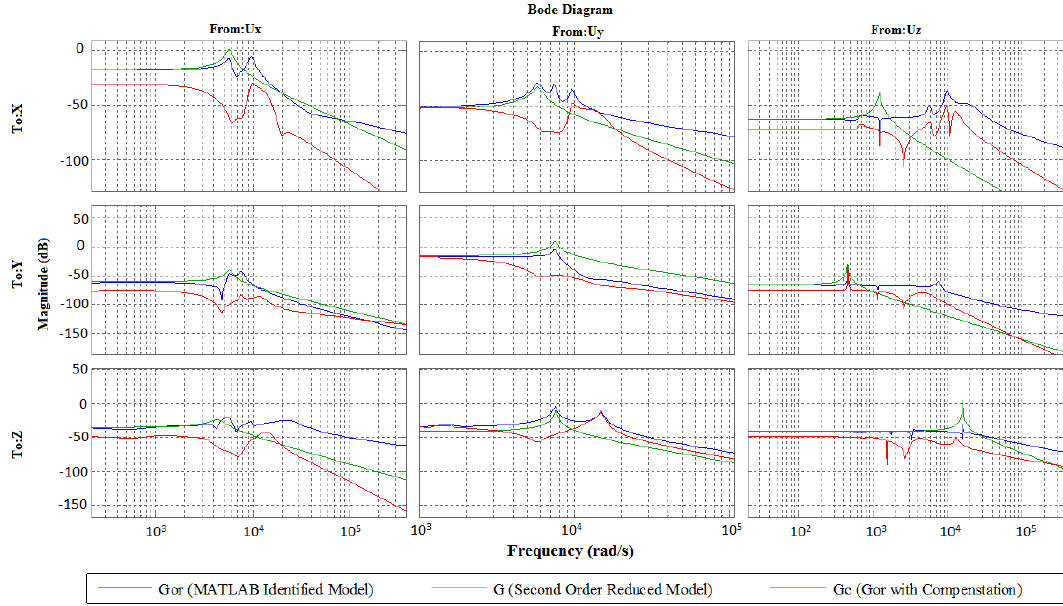
Figure 6. Bode plots for the identified, reduced and compensated models—simulation.